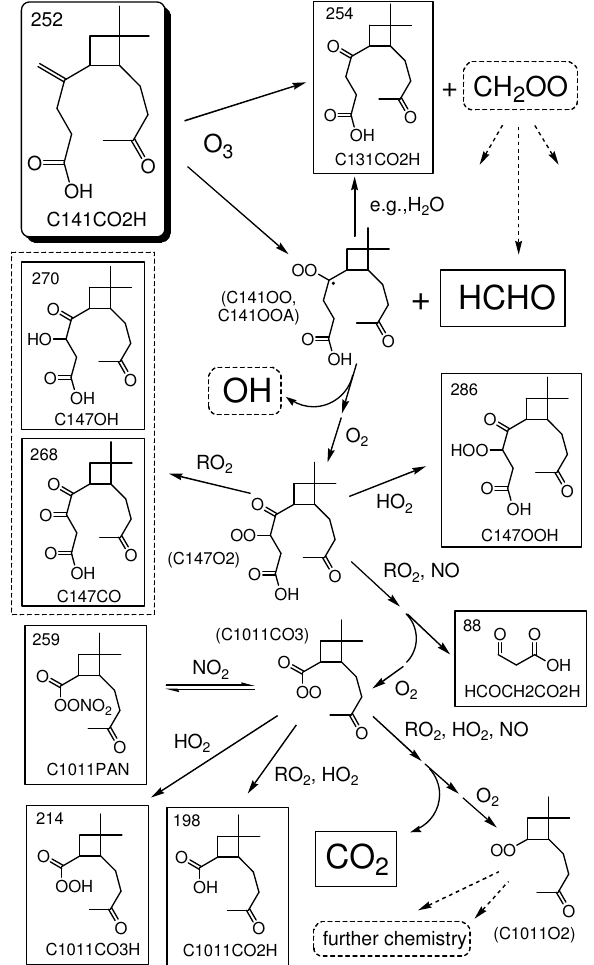
Figure 5. Mechanism and selected products of the ozonolysis of the major first-generation 2 Fig. 5. Mechanism and selected products of the ozonoly- sis of the major first-generation product, β -caryophyllonic acid product, E(cid:16) caryophyllonic acid (C141CO2H). The displayed values indicate the molecular 3 (C141CO2H). The displayed values indicate the molecular masses masses of the products. 4 of the